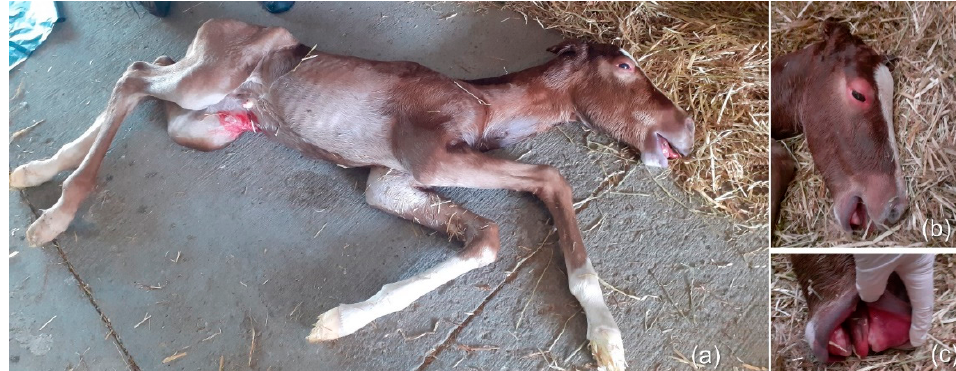
Figure 2. Macroscopic findings of the foal ( a ) foal at birth; ( b ) edema of the head, eyelids and lips; ( c ) congested mucous membranes.